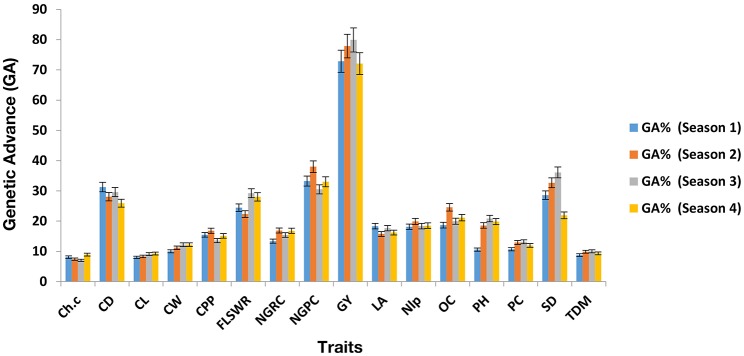
Genetic advance (GA) of under study traits in H9 (potential maize hybrid). The error bars are Standard errors (±).